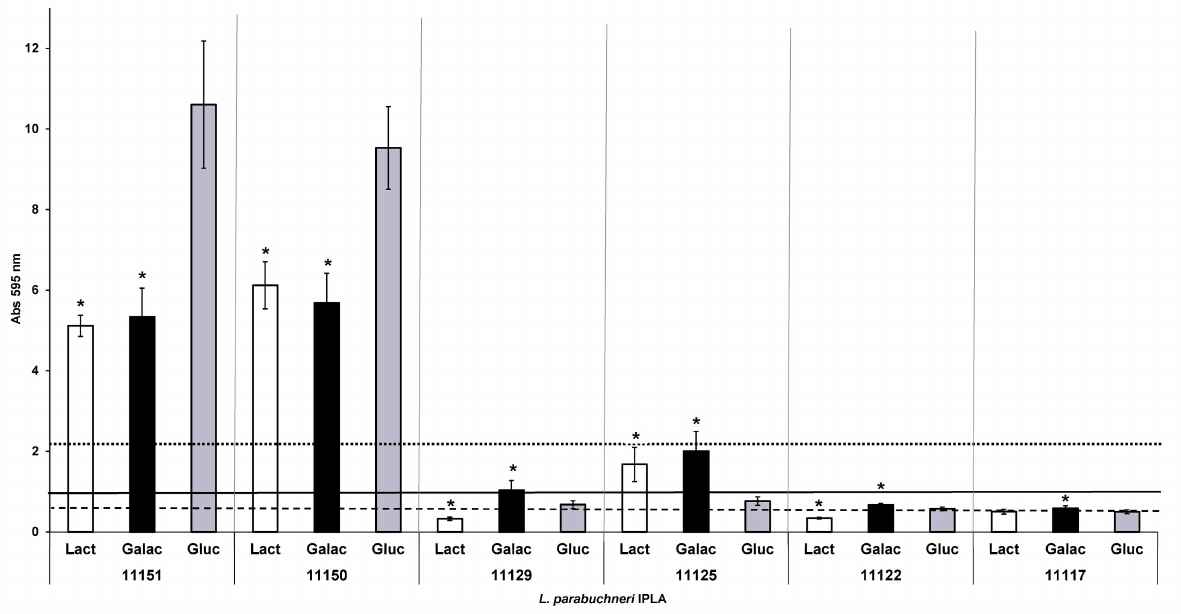
Figure 6. Biofilm-producing capacity on polystyrene of the histamine-producing L. parabuchneri strains incubated with MRS supplemented with different carbon sources. The strains were incubated for 48 h at 37 ◦ C. Data represent means ± SD (error bars) of three experiments. Values marked with * differ significantly, considering glucose as the control. The producer/nonproducer cut-off (weak producer) is signaled by the dashed line (ODc), the solid line is 2 × ODc (moderate producer) and the dotted line 4 × ODc (strong producer). Lact: Lactose; Galac: Galactose; Gluc: Glucose.